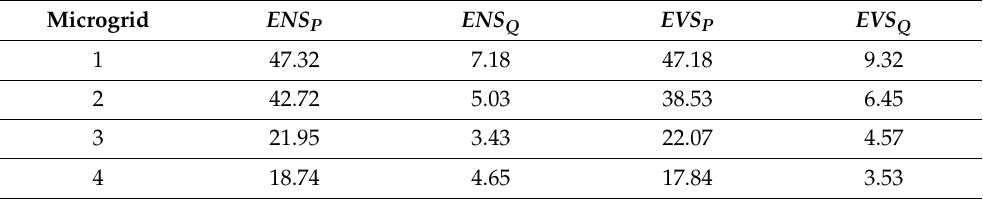
Table 4. Expected unmet energy supply (in terms of MWh and MVArh ) due to lack of active and reactive